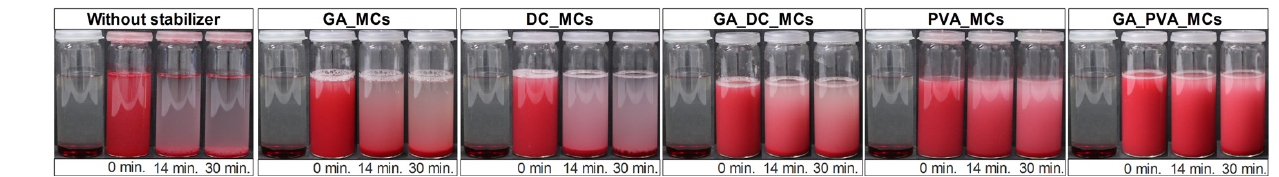
Figure 2. Visual observation of the emulsions used to obtain the GA, DC, GA_DC, PVA, and GA_PVA MCs, over a period of 30 min. From left to right: oil and water phase before emulsification, right after emulsification, 14 and 30 min after emulsification (static conditions).